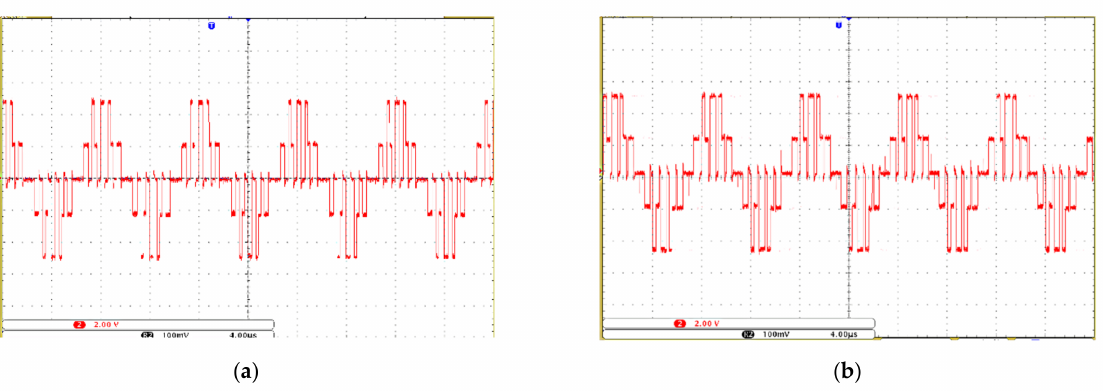
Figure 12. Comparison waveforms of line voltage by regulating voltage: ( a ) before regulating, ( b ) after regulating.